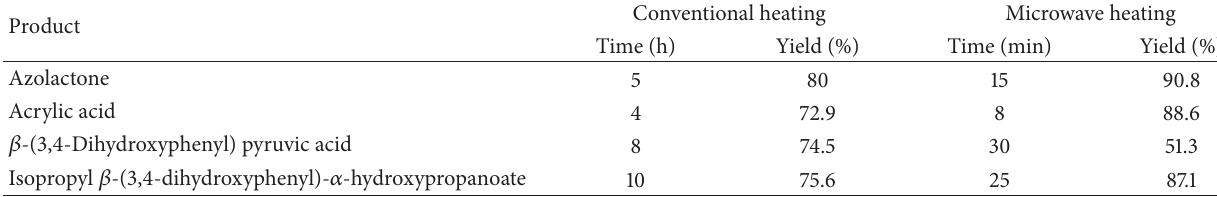
Conventional heating Microwave heating